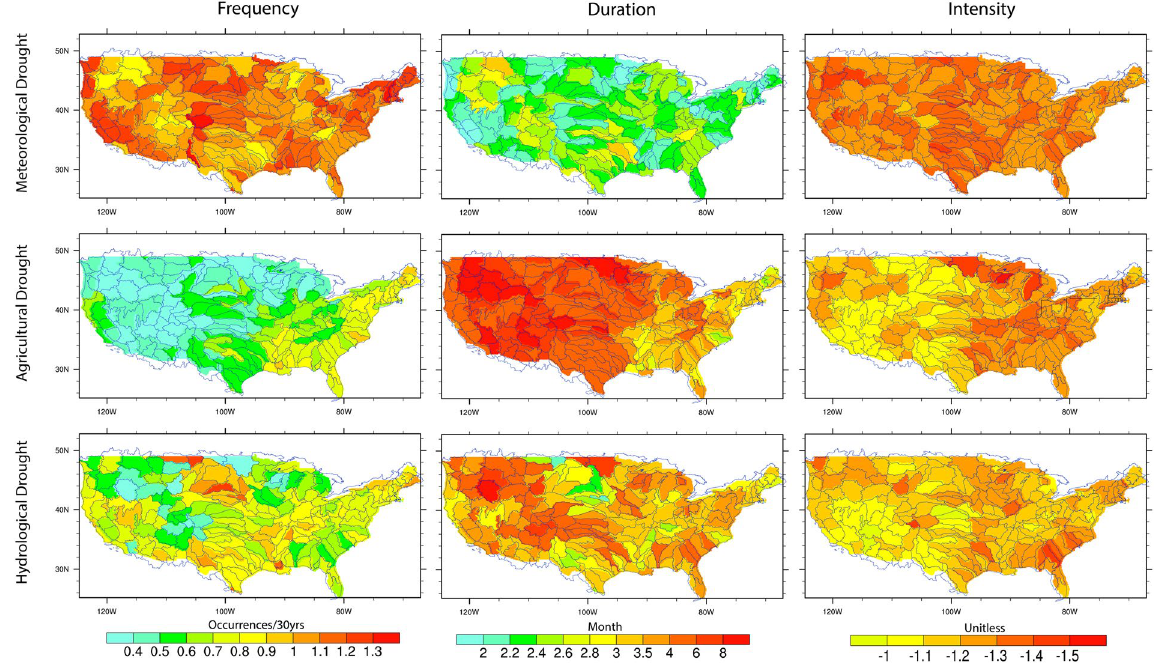
Figure 1. Spatial distribution of frequency (occurrences/30yrs), duration (months) and intensity (unitless) of meteorological, agricultural and hydrological droughts during 1971–2000. Meteorological drought is based on observed precipitation while hydrological and agricultural droughts are based on VIC simulated runoff and soil moisture driven by the observed climate, respectively. The frequency is referred to the number of drought occurrences for the given period while duration and intensity are for the climatology mean of those drought events. Figure was created by NCAR Command Language 81